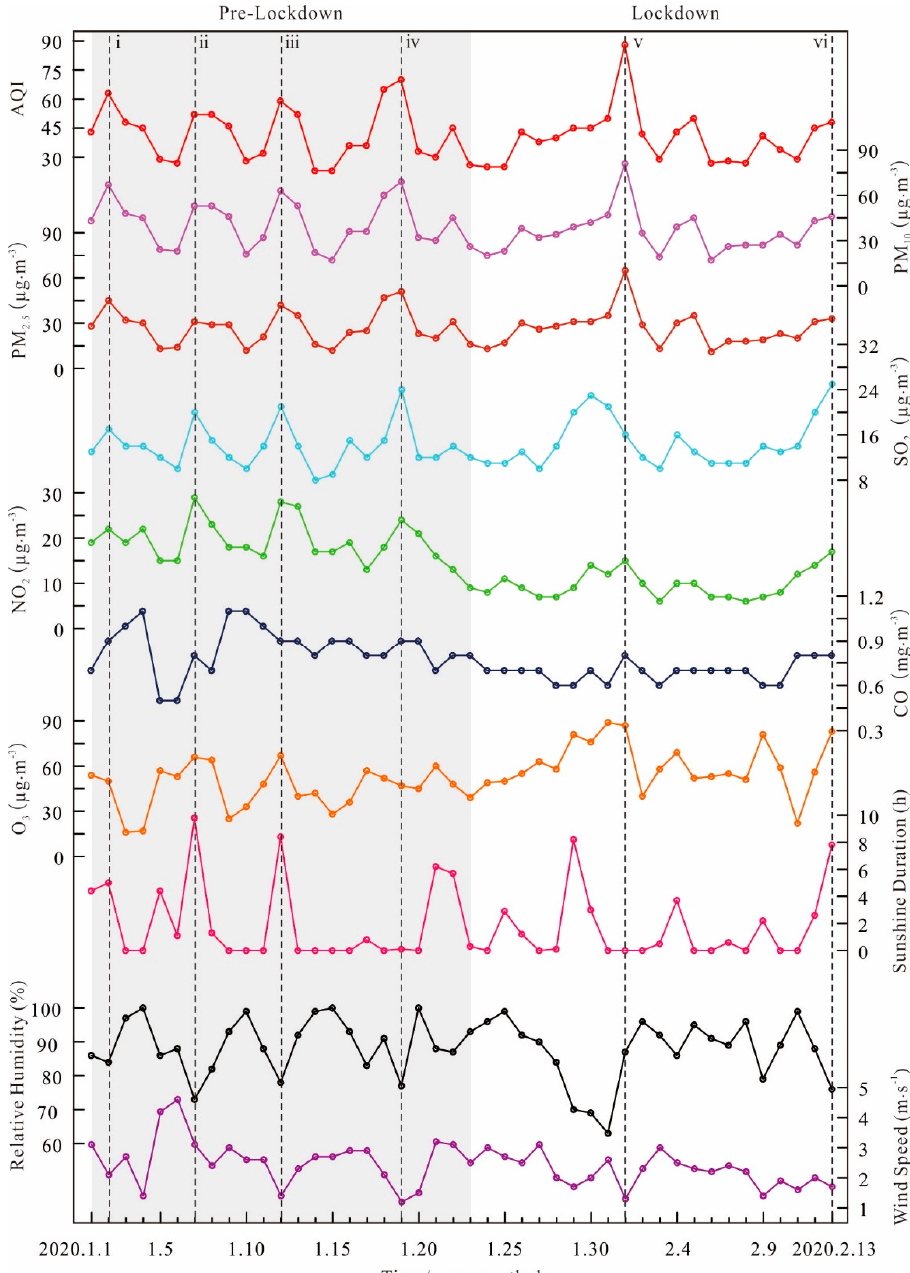
Figure 3. Daily variations of air quality during pre-lockdown and lockdown in 2020. Variations in meteorological conditions had a vital impact on changes in the con- centrations of pollutants, leading to large fluctuations in the concentrations of pollutants before and after lockdown, over a short period of time. In most cases, the peaks of PM 2.5 , PM 10 , SO 2 , and NO 2 concentrations correspond to the peaks of sunshine hours (Figure 3 ⅰ – ⅵ ), relative humidity valley values (Figure 3 i – ⅳ , ⅵ ), and wind speed valley values (Figure 3 ⅰ , ⅲ – ⅵ ), respectively. Due to the long sunshine hours, the temperature rose, and evapo- ration increased, thereby resulting in a decrease in the relative humidity and a dry sur- face. Accordingly, pollutants on the ground, especially dust, were more likely to fly into the air. Meantime, there was little wind, resulting in the pollution sources not being eas-